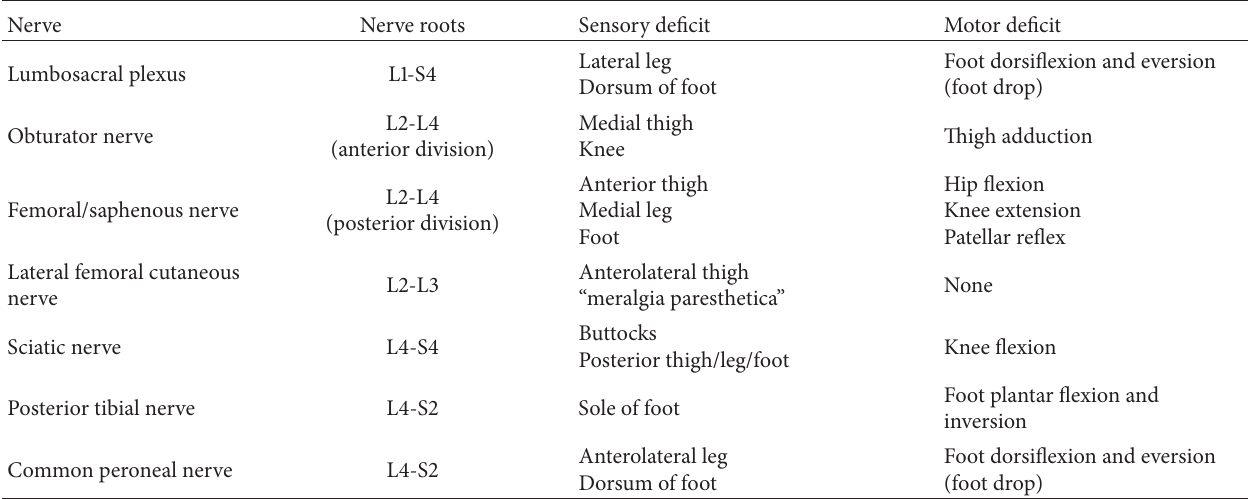
Table 1: Obstetric